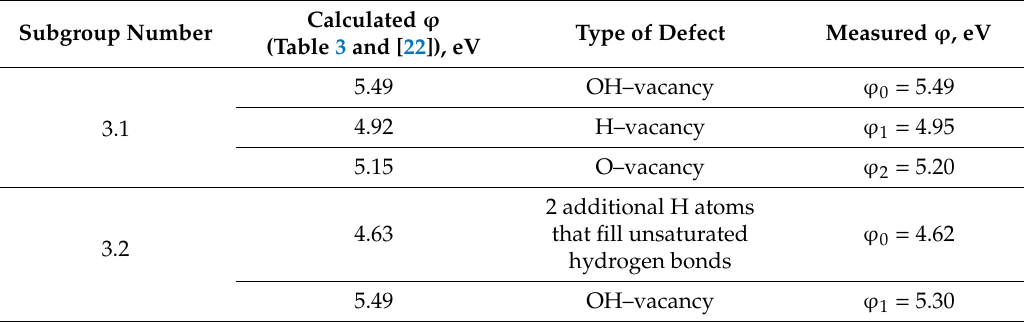
Table 10. Subgrouping of the samples of the group